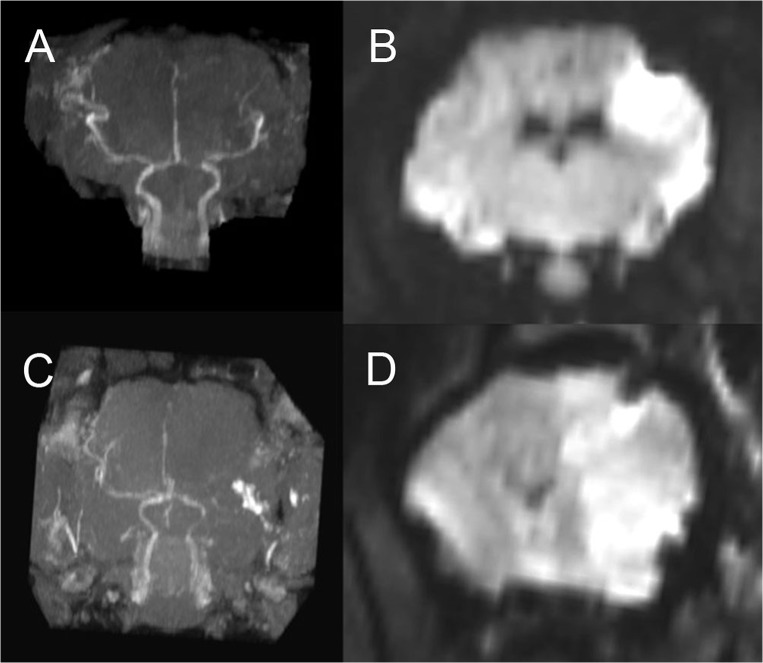
MRI findings at 24 hours following stroke: MRA and DWI.Temporary MCAO MRA demonstrates reperfusion in the right MCA territory (A), and diffusion deficit on DWI in the right MCA cortex (B). Permanent MCAO MRA shows no flow beyond the right proximal MCA (C), and a larger diffusion deficit involving the whole MCA territory including subcortical structures (D). DWI, diffusion weighted imaging; MCA, middle cerebral artery; MCAO, middle cerebral artery occlusion; MRA, magnetic resonance angiography, n = 6/gp.